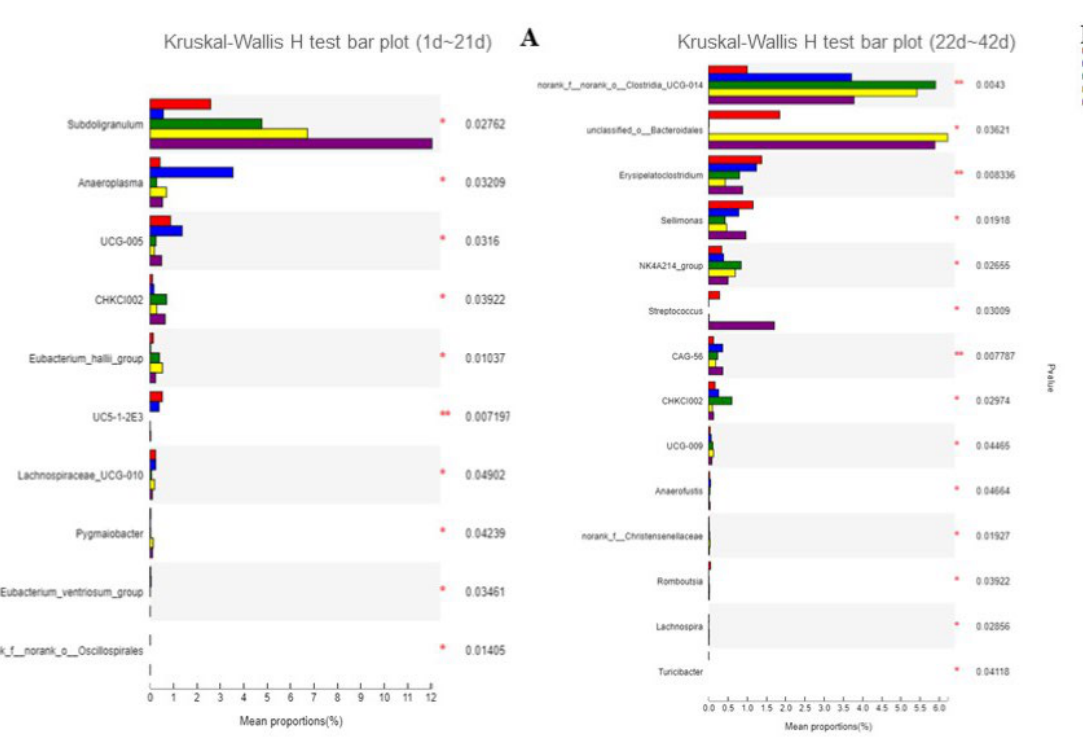
Figure 13. PCA analysis of each group at the genus level ( A ): the early stage (1~21d), ( B ): the late stage (22~42 d) (*: p < 0.05; **: p <